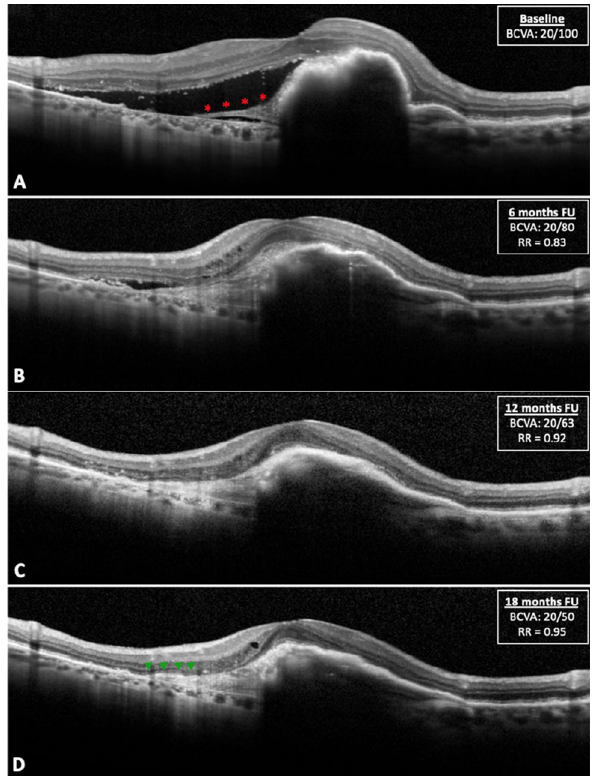
Figure 5. Formation and remodeling of the repair tissue on optical coherence tomography (OCT) over 18 months of follow-up. ( A ) shows a large retinal pigment epithelial (RPE) tear involving the fovea (grade 4) with several folds of the retracted RPE and direct exposure of the Bruch’s membrane; an initial proliferative tissue can be appreciated (red asterisks). After 6 months ( B ), some sort of subretinal hyperreflective tissue (SHT) almost completely covers the bed of exposed Bruch’s membrane. Over the follow-up, the relative reflectivity RR) of the repair tissue gradually increases ( C ) and in occasion of the last visit a distinct RPE layer covering the SHT can be noticed ( D , green